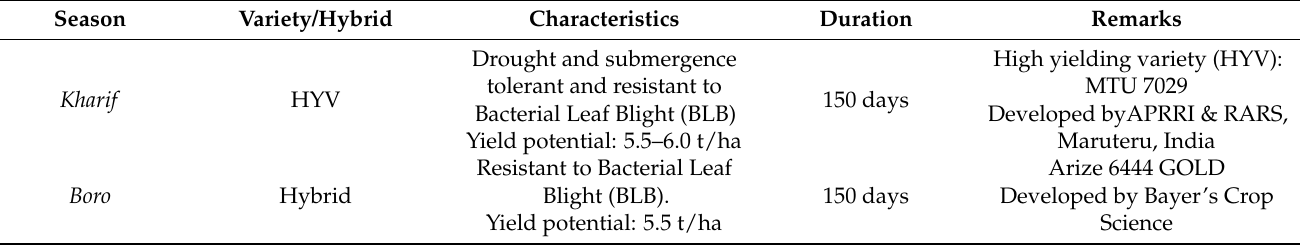
Table 2. Varietal details.